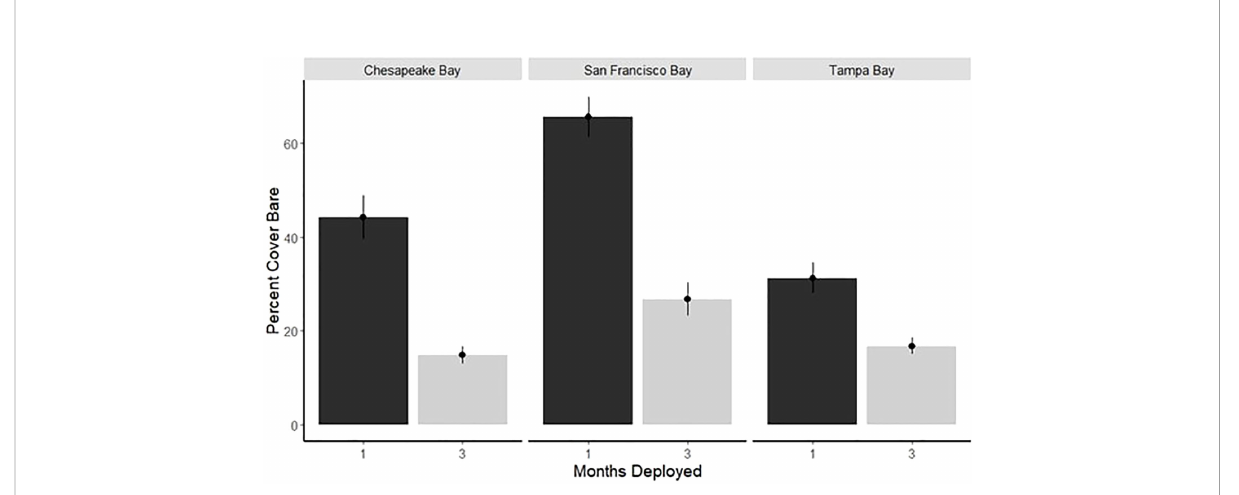
FIGURE 3 Average percent cover (± SE) of bare space by bay for 1- and 3-month panels deployed during period 1